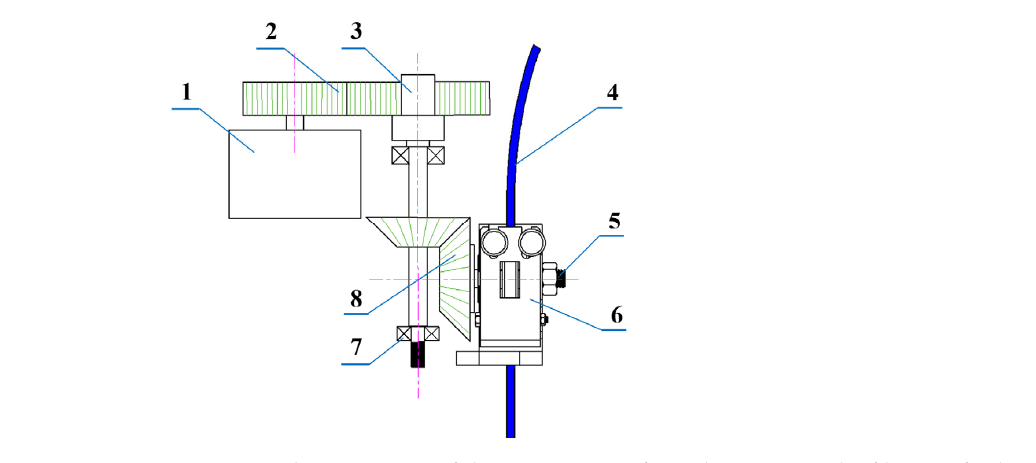
Figure 3. Schematic view of the transmission from the motor to the filament feeder. 1—Stepper motor; 2—Sun spur gears; 3—Planet spur gear; 4—Housing shaft; 5—Filament; 6—Knurled bolt; 7—Filament feeding mechanism; 8—Ball bearing; 9—Bevel gears.